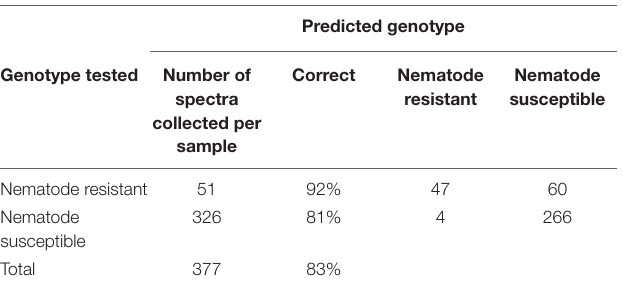
TABLE 10 | 80:20 prediction and validation